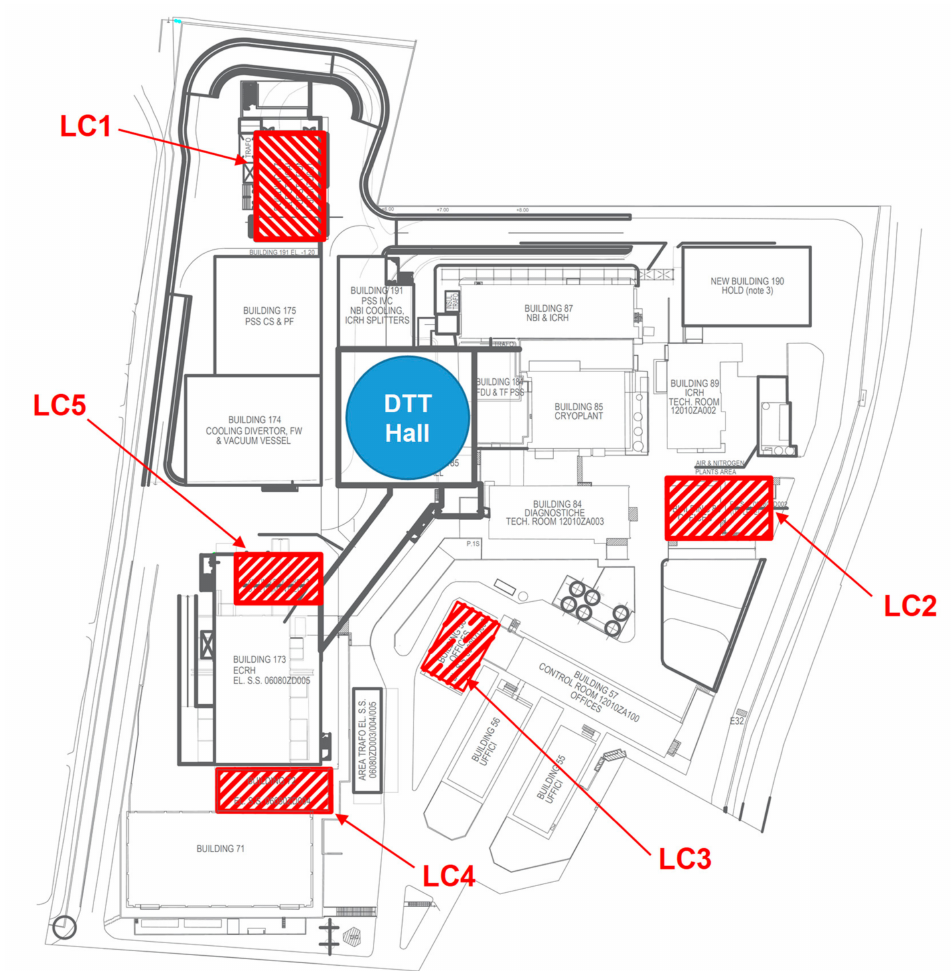
Figure 3. Layout of DTT facility, with a focus on the 5 LCs. All the services are used for the operation of the tokamak located inside the DTT